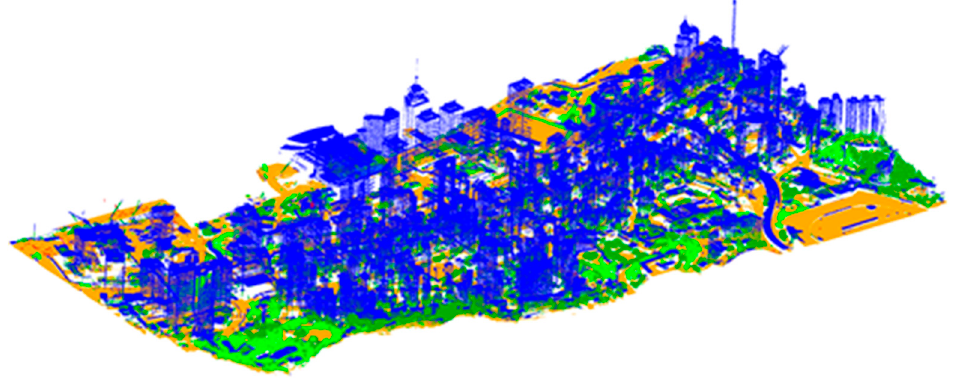
Figure 12. The semantic labeling results of the Hong Kong dataset using the proposed method in 3D.